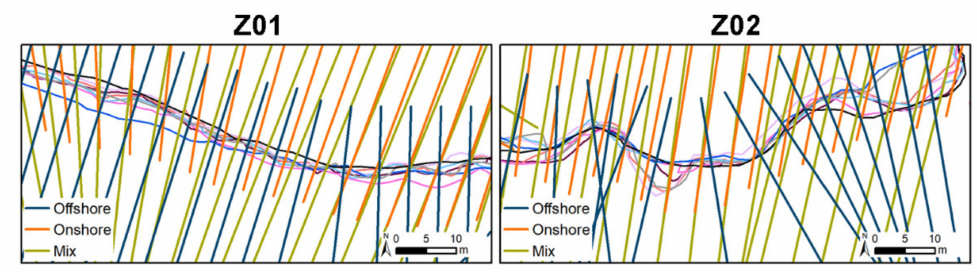
Figure 9. Variation in the transects orientation using different baselines in ODSAS. Both zones are in Site A04, and their positions appear in Figure